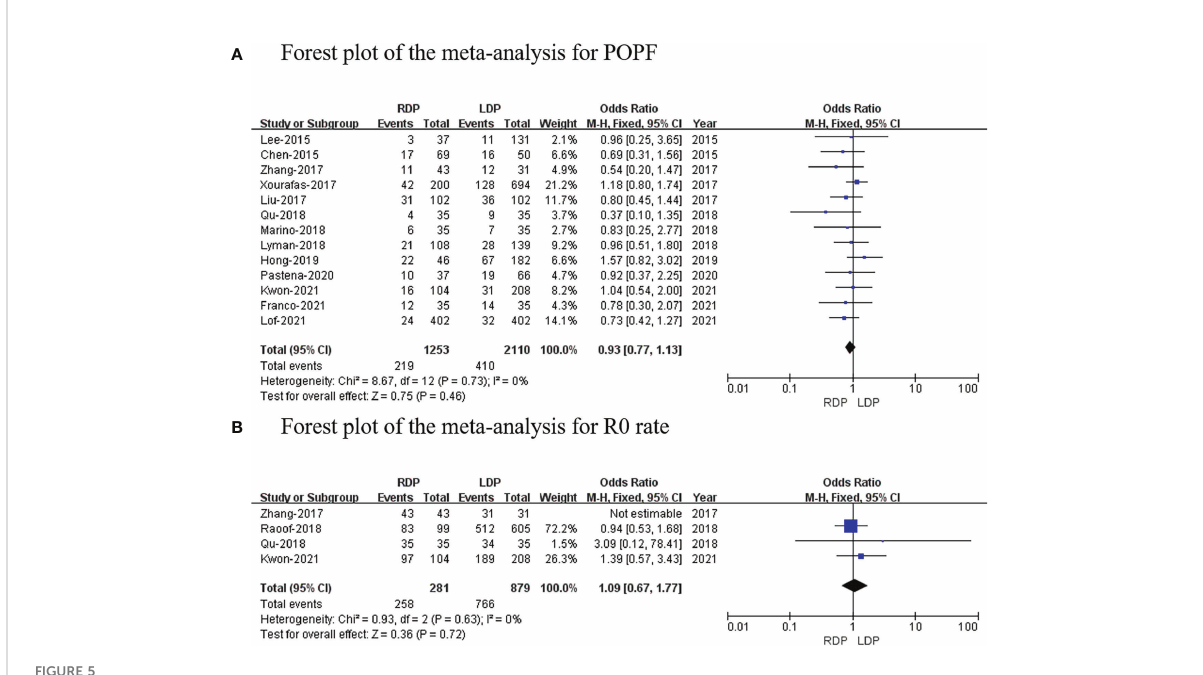
FIGURE 5 Forest plot of the meta-analysis for (A) postoperative pancreatic fi stula and (B) R0